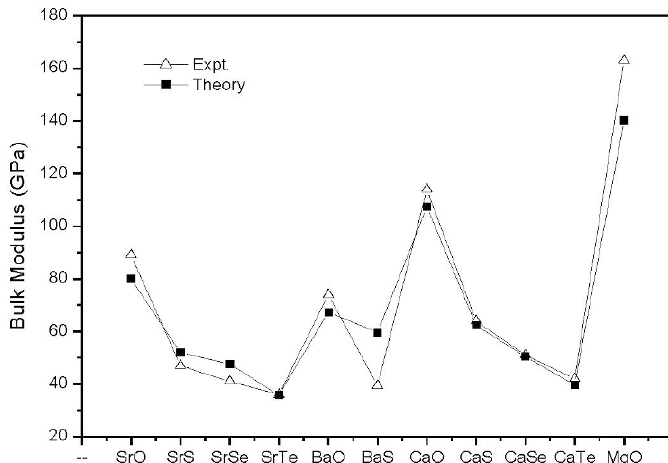
Figure 10. Phase transition pressure and Volume collapse of alkaline earth